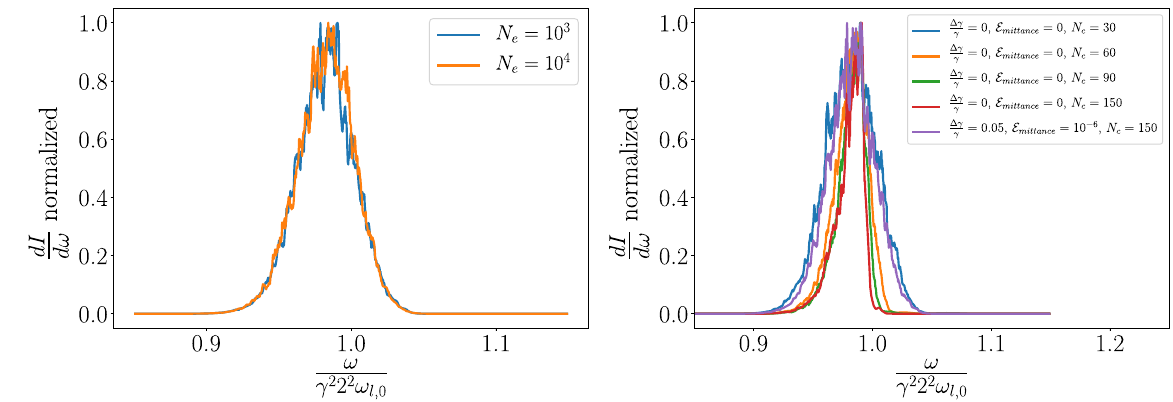
¼ 1 FIG. 1. Calculated spectra ( dI ) within ϑ for a circularly polarized PW laser pulse with parameters a 0 ¼ 10 − 1 , ω l; 0 ¼ d ω 10 γ max 1 . 77 × 10 15 [ 1 ] and electron parameters σ x;y ¼ 15 × 10 − 4 ½ cm (cid:2) , σ z ¼ 15 . 75 × 10 − 4 ½ cm (cid:2) , γ ¼ 10 3 . Left: spectra as function of the s ¼ 0 . 05 and E ¼ 10 − 6 ½ mm mrad (cid:2) . From the results we conclude that N number of macro particles ( N e ) with Δ γ γ mittance sufficient accuracy for the purpose of this study. Right: spectra as function of N c and an ideal electron bunch: Δ γ ¼ 0 ½ mm mrad (cid:2) . It also includes a realistic electron bunch with Δ γ ¼ 0 . 05 and E ¼ 10 − 6 ½ mm mrad (cid:2) for the PW N E γ mittance mittance case (purple). The bandwidth of the emitted radiation for N c ¼ 30 and an ideal electron bunch roughly equals that of N c ¼ 150 and realistic